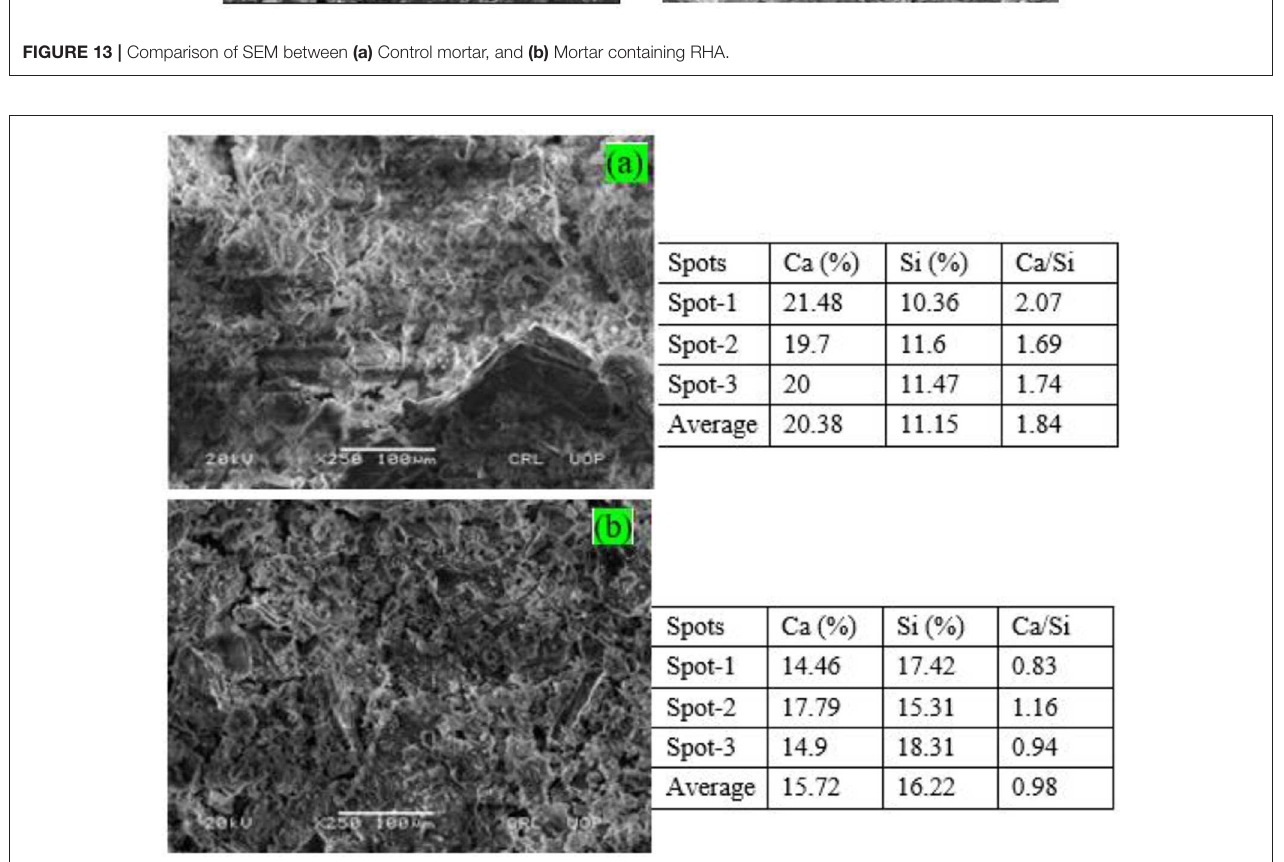
FIGURE 14 | Ca/Si ratio at 91 days in (a) Control mortar, and (b) Mortar containing RHA.